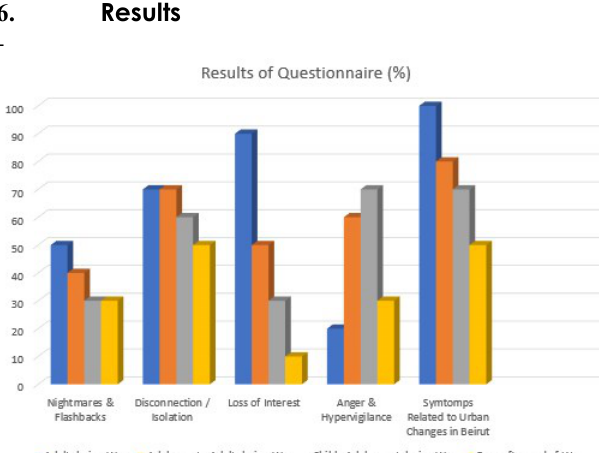
Figure 7. Results of the questionnaire showing degrees of PTSD symptoms among the participants according to their